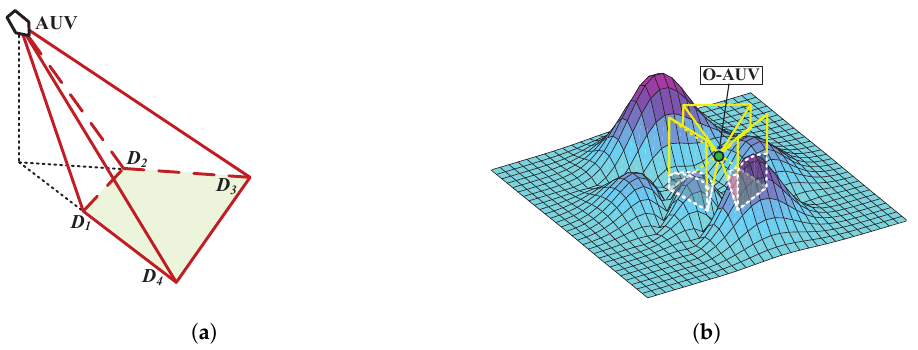
Figure 3. Motivation of information collection model. ( a ) Schematics of the monitoring area. ( b ) 3D sensing model of the